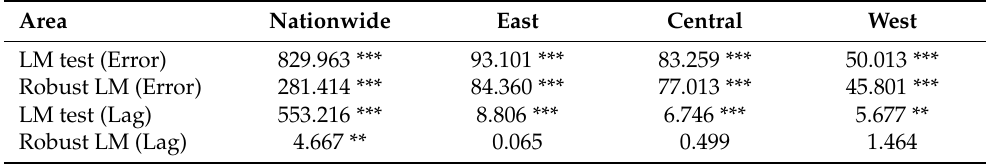
Table 3. LM test results.